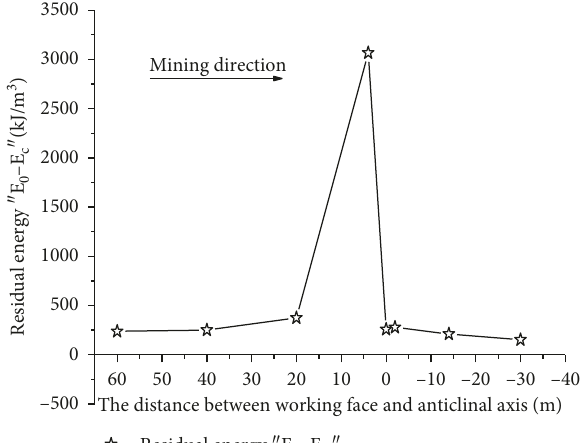
Figure 10: The “ E